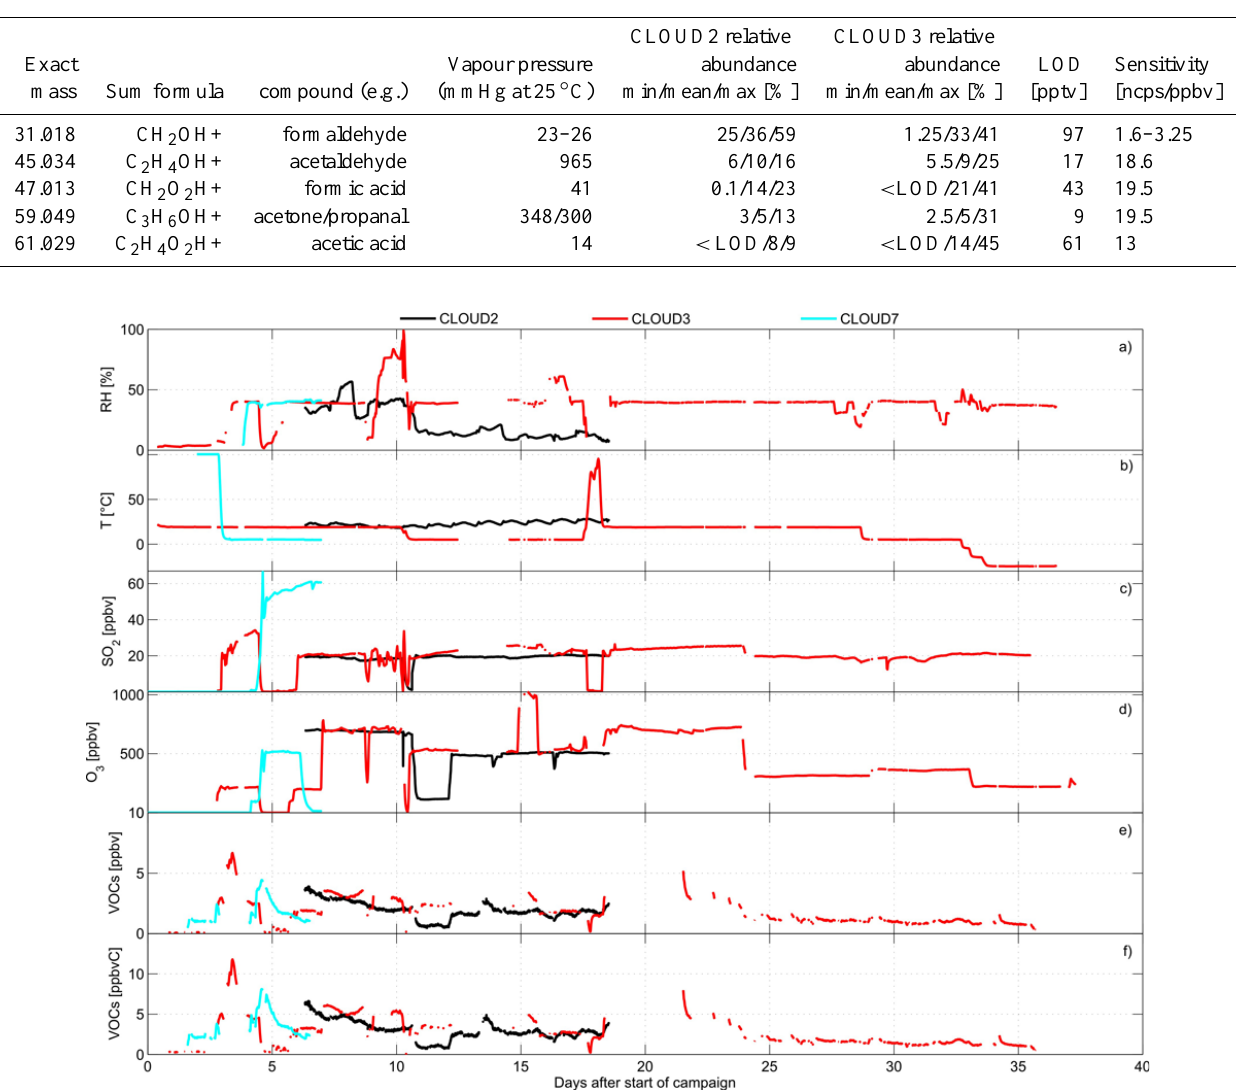
Table 1. Vapour pressure (from http://www.chemspider.com, Kroll and Seinfeld, 2005), individual abundance (CLOUD2 and CLOUD3), limit of detection (LOD), and sensitivity of the most predominant (about 75% of the total VOC volume mixing ratio) peaks detected by PTR-ToF during CLOUD3.